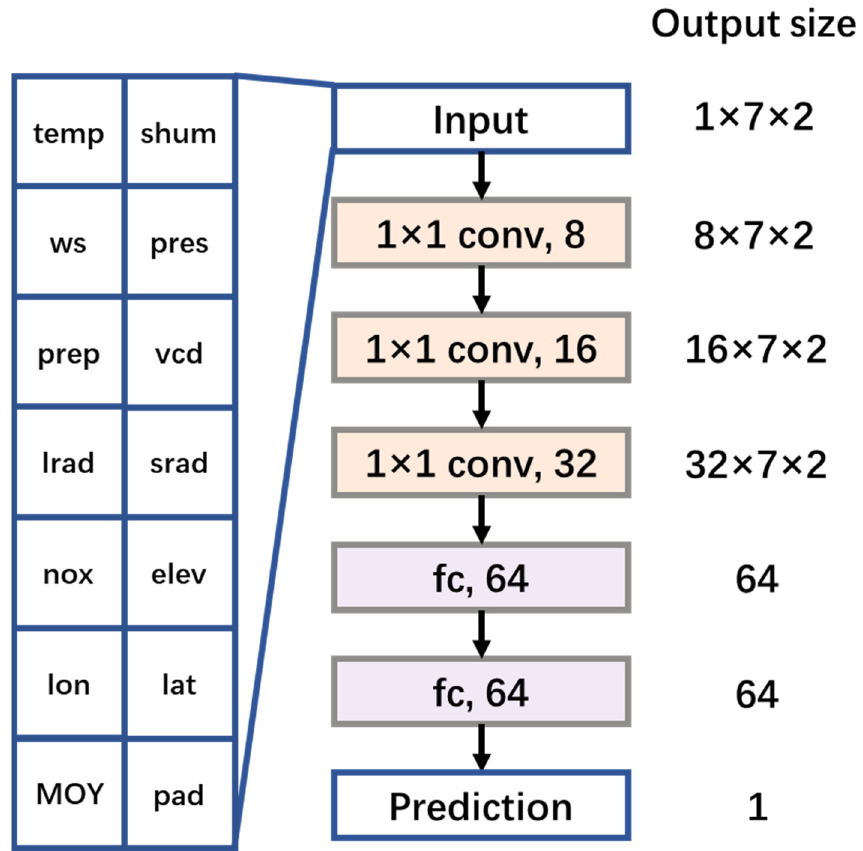
Figure 5. Structure of the convolutional neural network for nitrate deposition prediction.